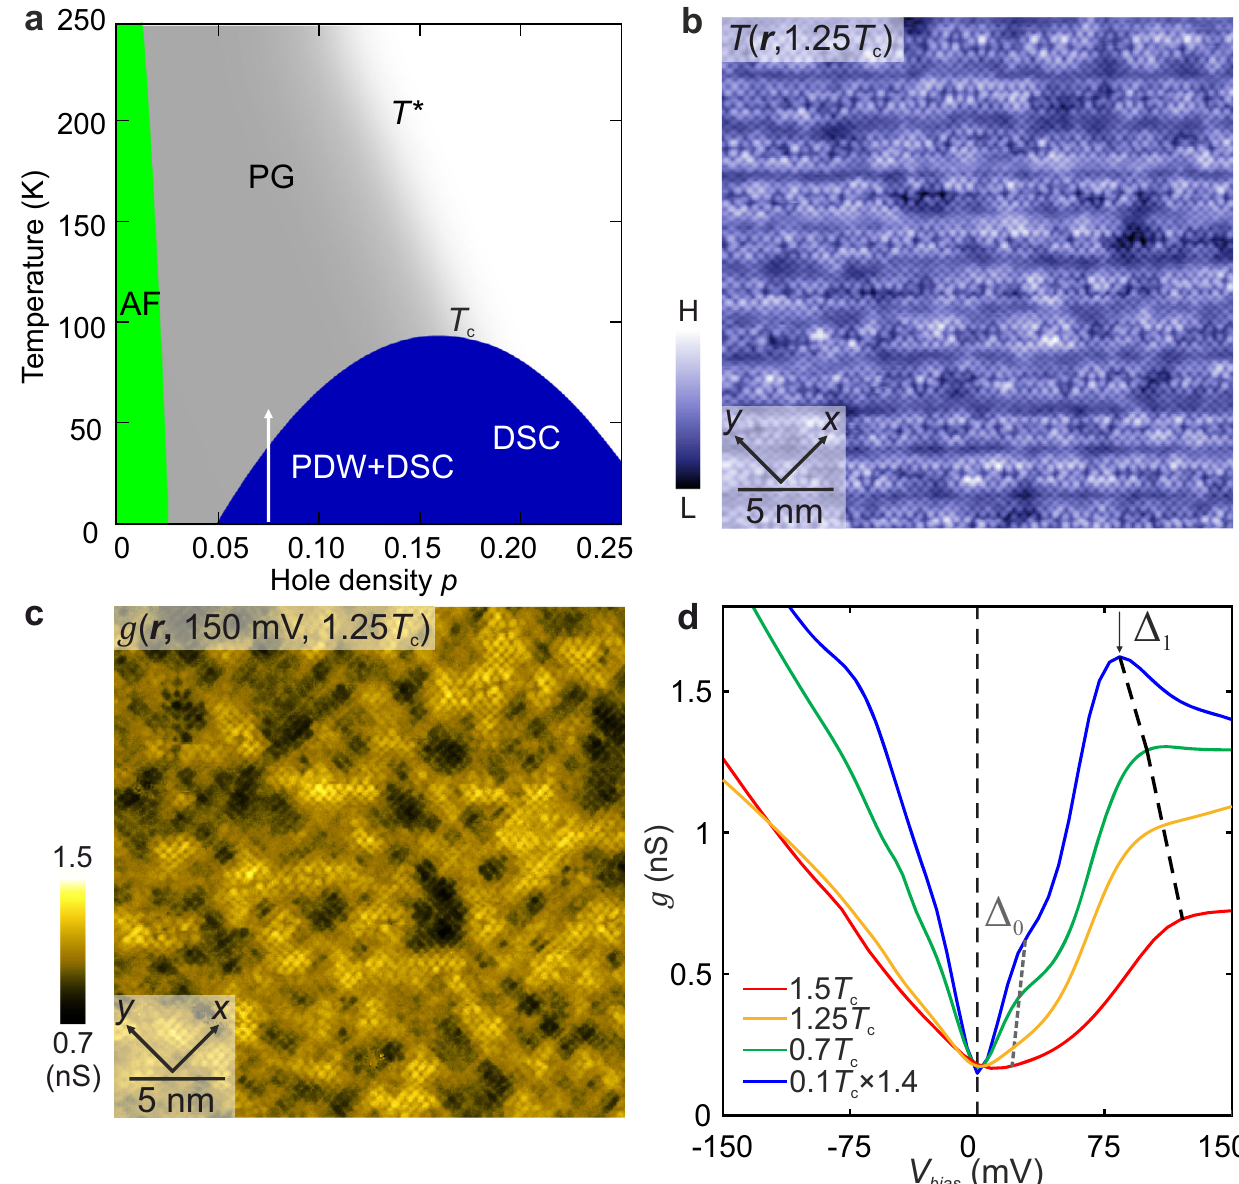
Fig. 1 Temperature dependence of cuprate broken-symmetry states. a Schematic phase diagram of hole-doped cuprates. The Mott insulator phase with long range antiferromagnetic order (AF) is replaced by the pseudogap phase (PG) with increasing hole doping p below the onset temperature T *. The PG phase is characterized by the suppression of magnetic susceptibility, electronic speci fi c heat, the c-axis conductivity and the average density of electronic states, and the appearance of a truncated Fermi surface. The d-symmetry Cooper-paired high-temperature superconductivity state (DSC) is indicated schematically in a blue “ dome ” . The range of temperature T , in which the PG state is studied in this paper is indicated by the white arrow. b Topograph T ( r ) at the BiO termination layer at T = 1.25 T c in the PG phase of Bi 2 Sr 2 CaDyCu 2 O 8 for p ≈ 0.08. c Differential conductance map g r ; þ 150 mV ð at the same fi eld of view as ( b ) at T = 1.25 T c = 45 K. The g ( r , E) manifests λ ¼ 4 a 0 charge modulations. d Evolution of the spatially averaged tunneling ð T Þ is the energy of the coherence peak that is identi fi ed conductance spectra of Bi 2 Sr 2 CaDyCu 2 O 8 with increasing T , here characterized by T c . The gap 4 1 by a local maximum in g (V) for V>0 (indicated by a black vertical arrow). The energies 4 0 ð T Þ (gray dashed line) are identi fi ed as the extinction energy of ð T Þ appear more subtle at higher temperatures due to thermal Bogoliubov quasiparticles (see movie S1). The two characteristic energies 4 T ð Þ and 4 0 1 broadening. Note the tunneling spectra at 4.2 K ( ≈ 0.1 T c ) is multiplied by